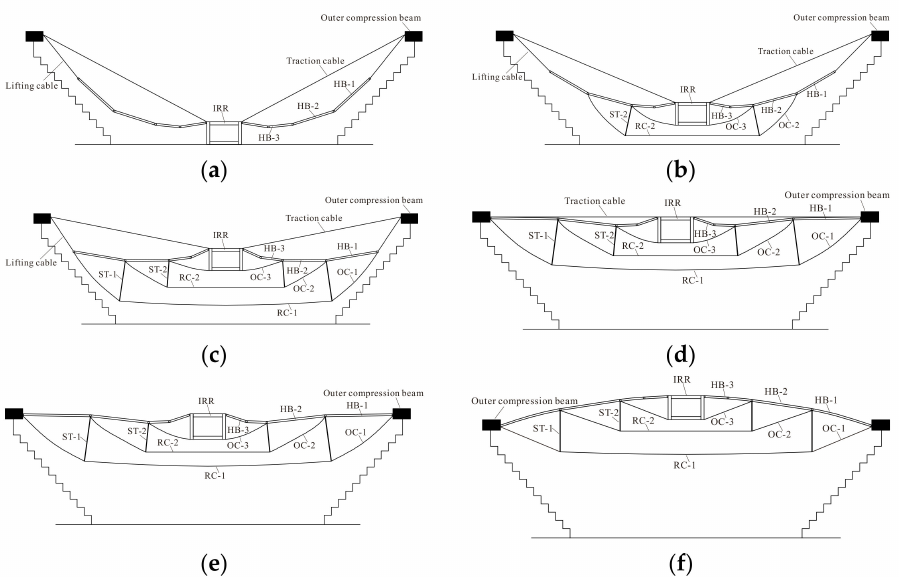
Figure 14. The detailed process of accumulative traction-hoisting construction technology. ( a ) Install outer compression beam, lifting cables, HBs, and IRR, connect the lifting cables to the outer compression beam, and connect the IRR and lifting cables to the HBs; ( b ) Shorten the lengths of the lifting cables and traction cables to lift the IRR for a short distance, and installing the OC-3s, ST-2s, RC-2, and OC-2s under the HB grid; ( c ) Lift the IRR for a short distance, install the OC-1s, ST-and RC-1; ( d ) Lift the IRR by lifting cables and traction cables until the outmost ends of HB-1s are connected to the outer compression beam; ( e ) Remove lifting cables and traction cables; ( f ) Tension the